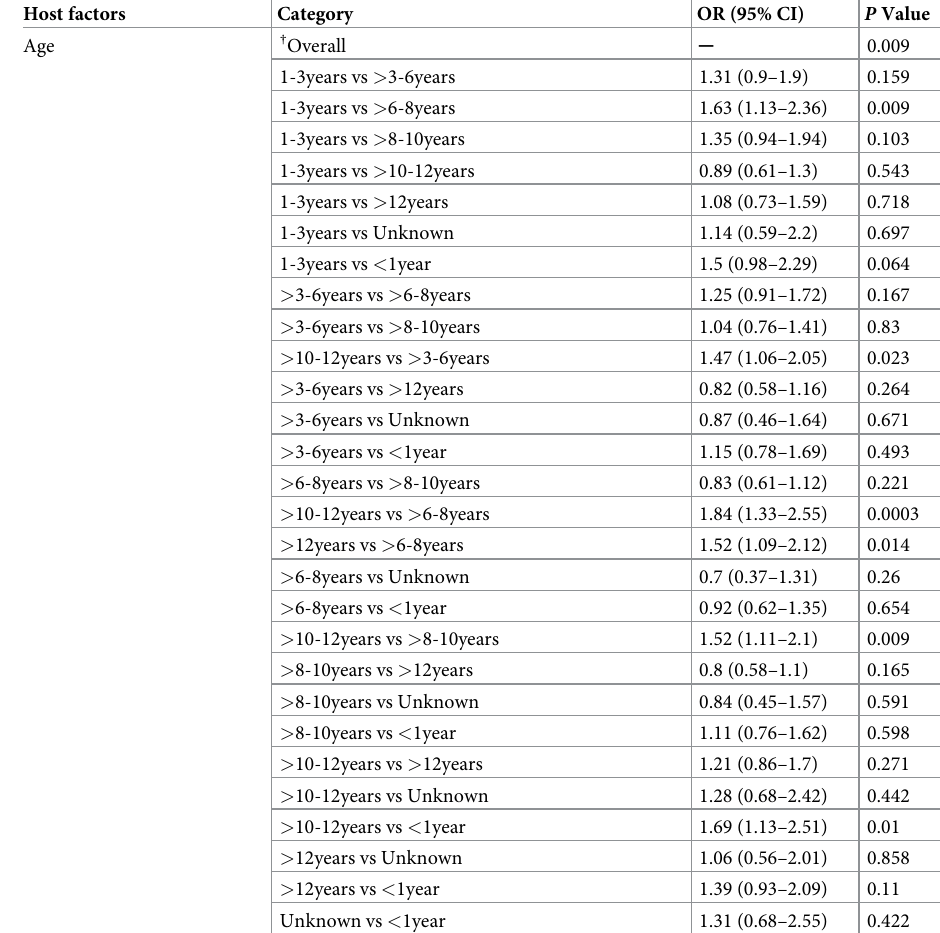
Table 7. Multivariable binary logistic regression model of the associations between host factors and antimicrobial resistance among Escherichia coli isolated from samples from